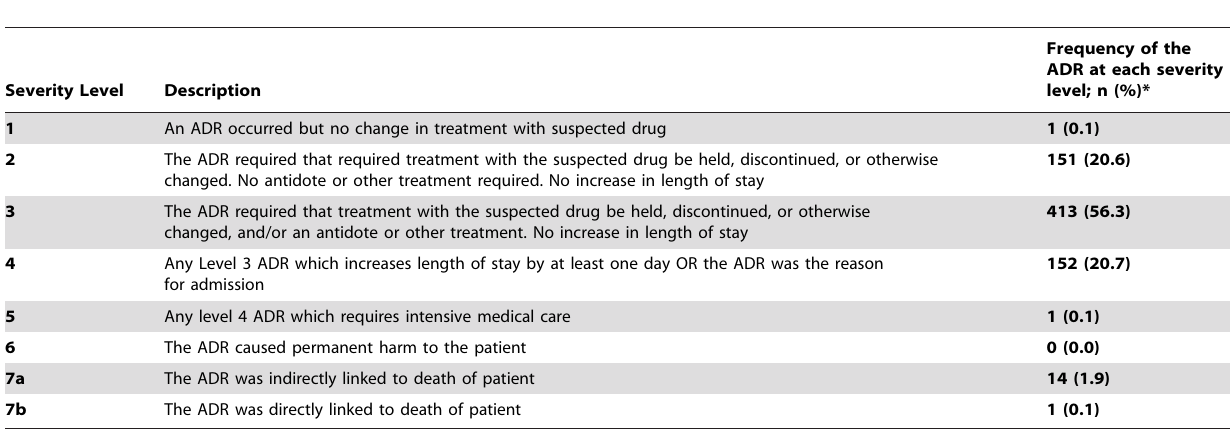
Table 3. The adapted Hartwig severity scale and corresponding adverse drug reaction (ADR) frequency.